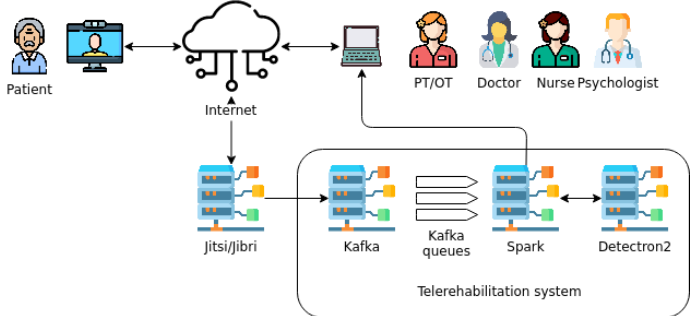
Figure 2. Schematic view of the different components of the telerehabilitation system.